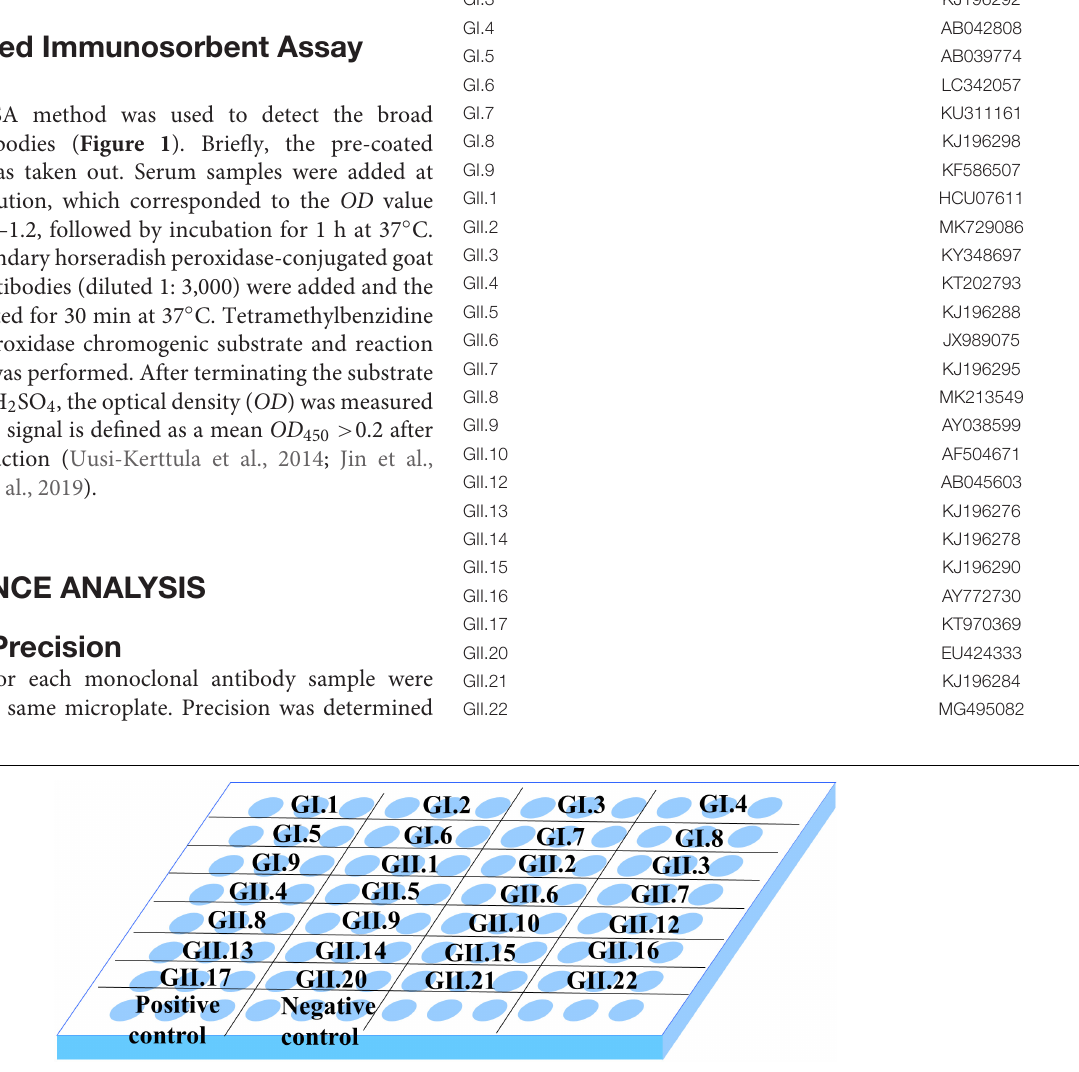
Frontiers in Microbiology |